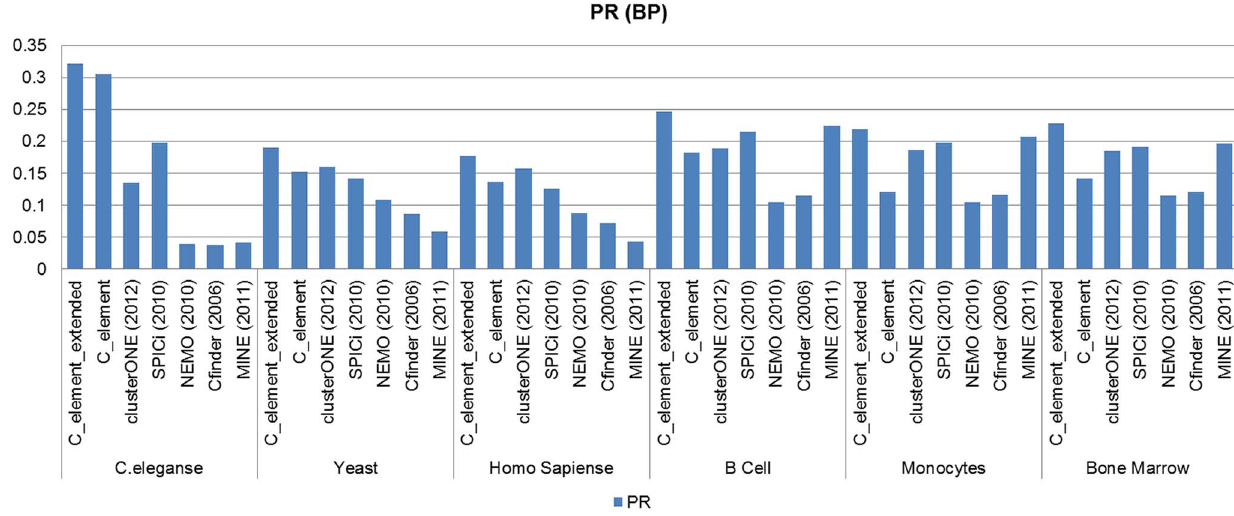
Figure 10. The Precision–Recall measure analyses results on the results of different algorithms on the six different network datasets when GOCC derived functional modules were considered.